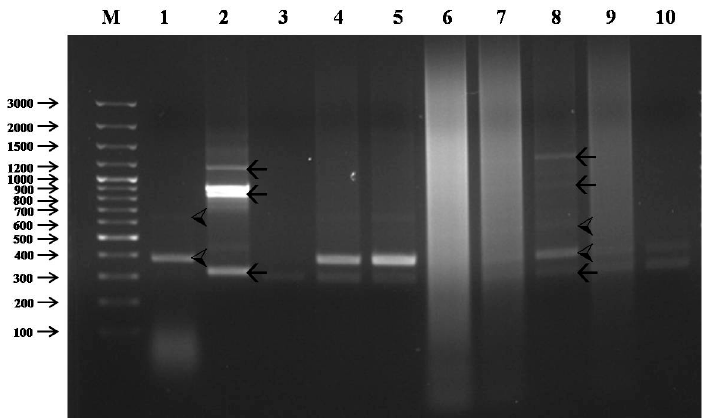
Figure 5. Confirmation of the hybridity of the intergeneric hybrids by randomly amplified polymorphic DNA (RAPD) marker; — J . curcas L. specific bands; — R . communis L. specific bands; Lane M—ladder;